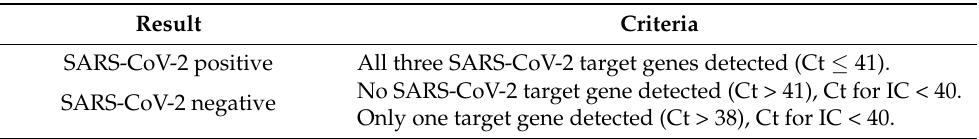
Table 1. Criteria used for the evaluation of rRT-PCR (SARS-CoV-2 nucleic acid detection kit) results.